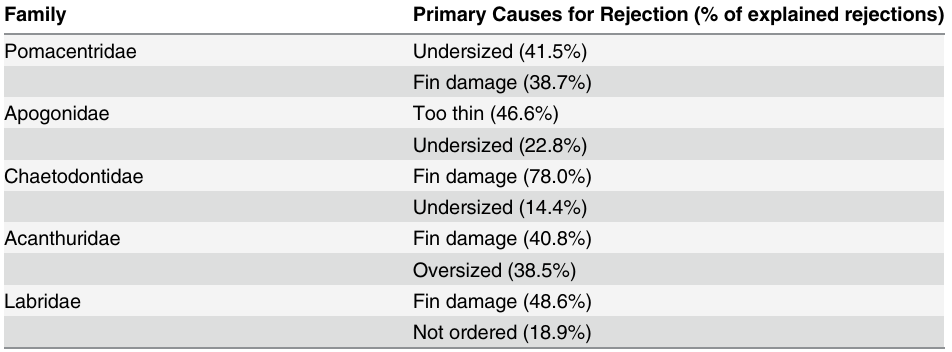
Table 2. Primary causes for rejection of fish from the five most collected